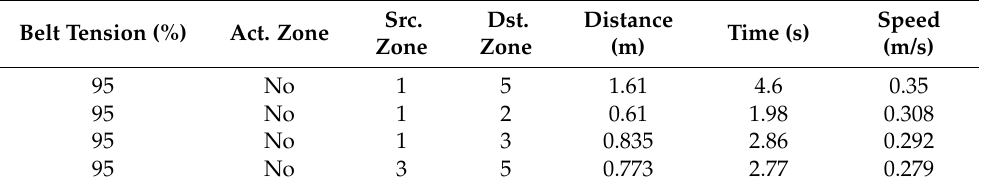
Table 8. Dynamic case results for 95% belt tension with active zones. Belt Tension